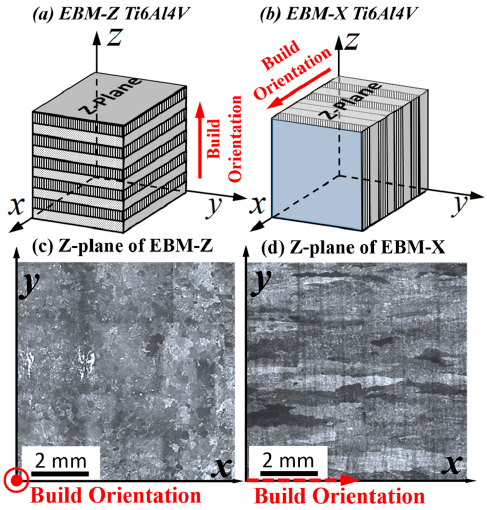
Figure 2. Graphical illustration of specimen preparation: ( a ) Electron beam melting (EBM) layered in Z direction (EBM-Z); ( b ) EBM layered in X-direction (EBM-X); ( c ) equiaxed grain morphology of EBM-Z Ti6A14V; ( d ) columnar grains of EBM-X Ti6Al4V.